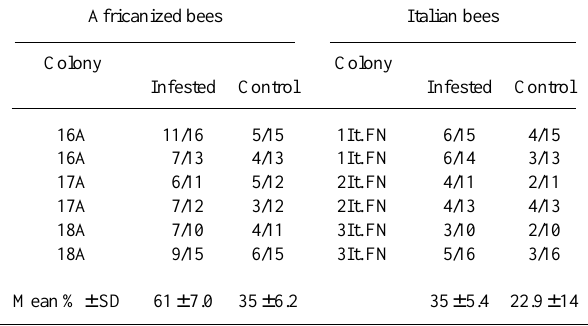
Table III - Proportion (number removed/number infested) of worker pupae artificially infested with Varroa jacobsoni removed in Africanized (A) bees vs. Italian bees from the Island of Fernando de Noronha (It. FN), Brazil, with respective controls (cells opened but no mites introduced). Africanized